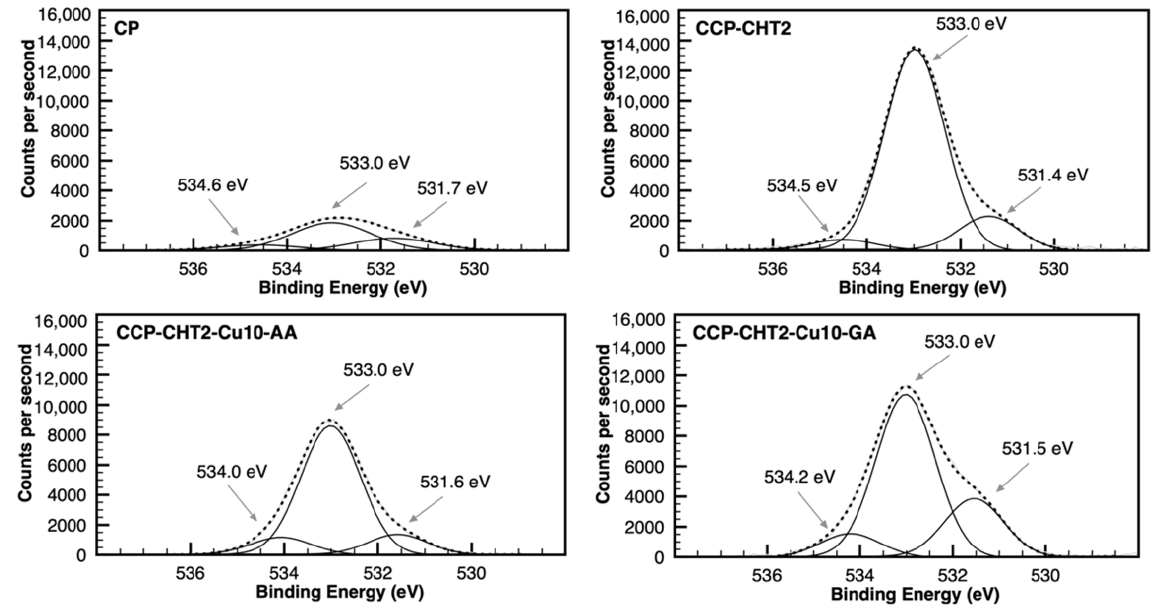
Figure 7. Gaussian deconvolution of high-resolution XPS O 1s spectra from CP, CCP-CHT2, CCP-CHT2-Cu10-AA, and CCP-CHT2-Cu10-GA samples.